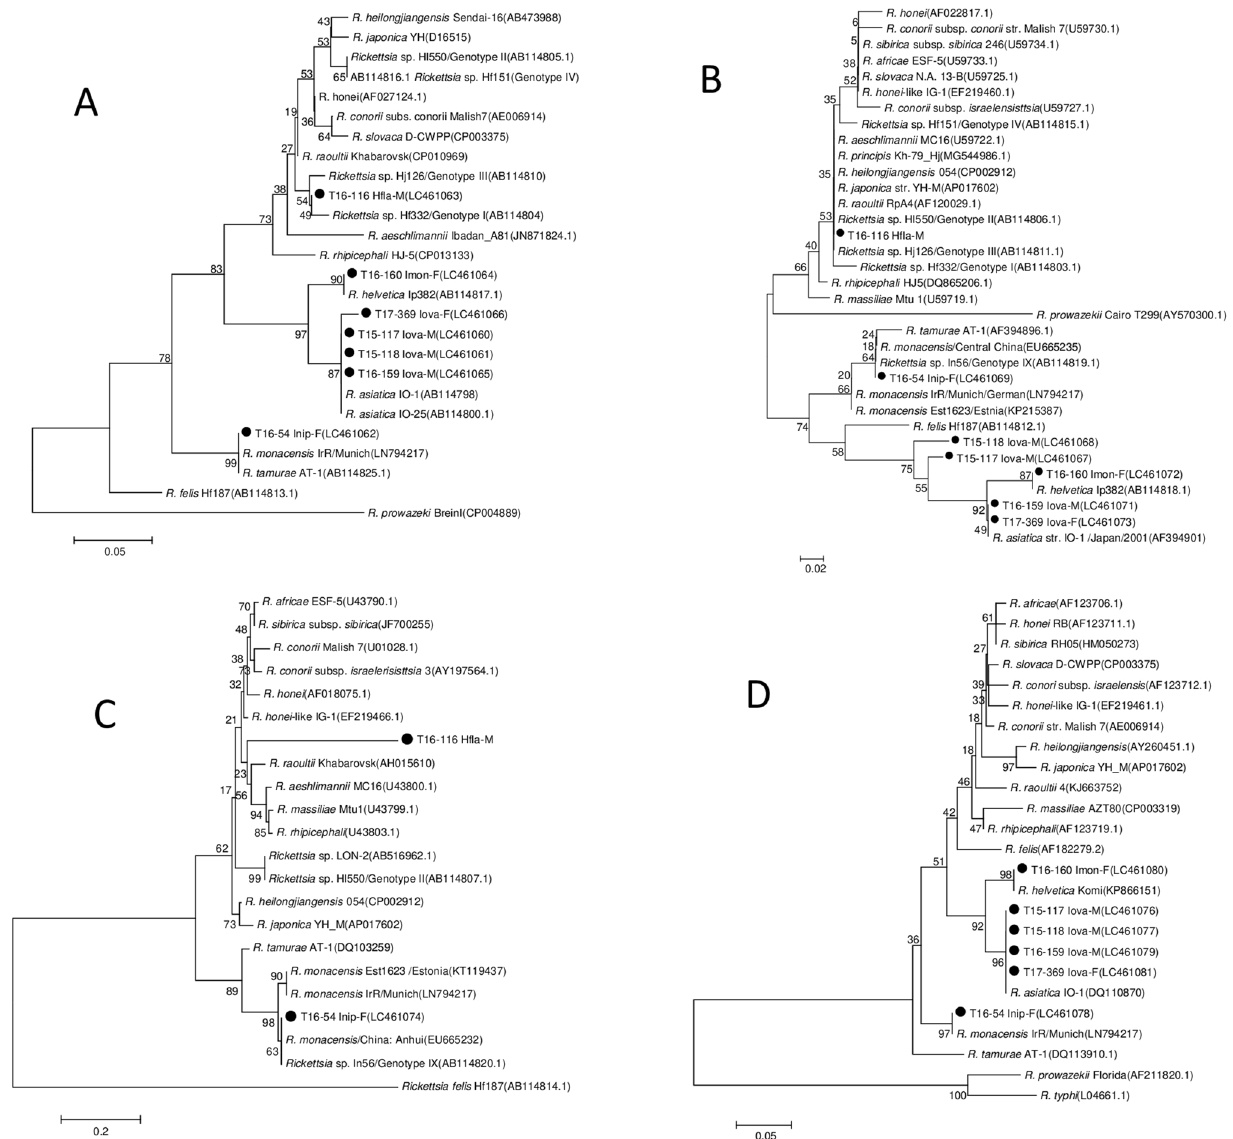
Figure 2. Phylogenetic analysis for identification of species of Rickettsiae based on 450 nucleotides of 17 kDa gene (A) , 382 nucleotides of gltA gene (B) , 540 nucleotides of rO mpA gene (C) and 426 nucleotides of rO mpB gene (D) . Sequence were aligned by using MEGA5 software (https ://www.megas oftwa re.net). Neighbor-joining phylogenetic tree construction and bootstrap analysis were performed according to the Kimura 2-parameter distances method. Bold-face font indicate positive samples detected from ticks in this study (shown only representative sample no. from among detected